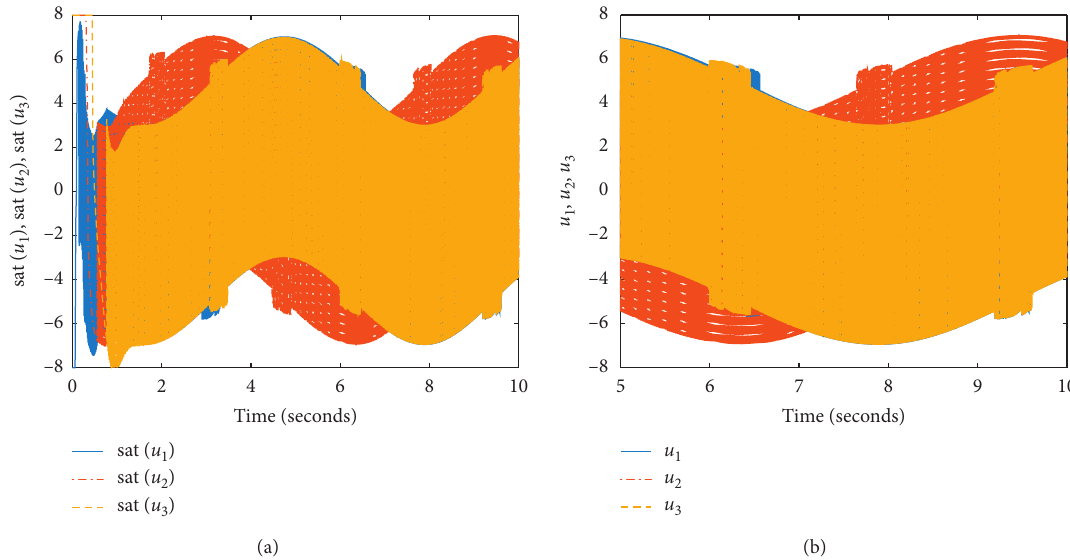
Figure 2: The trajectories of (a) sat ( u period [5 s, 10s].